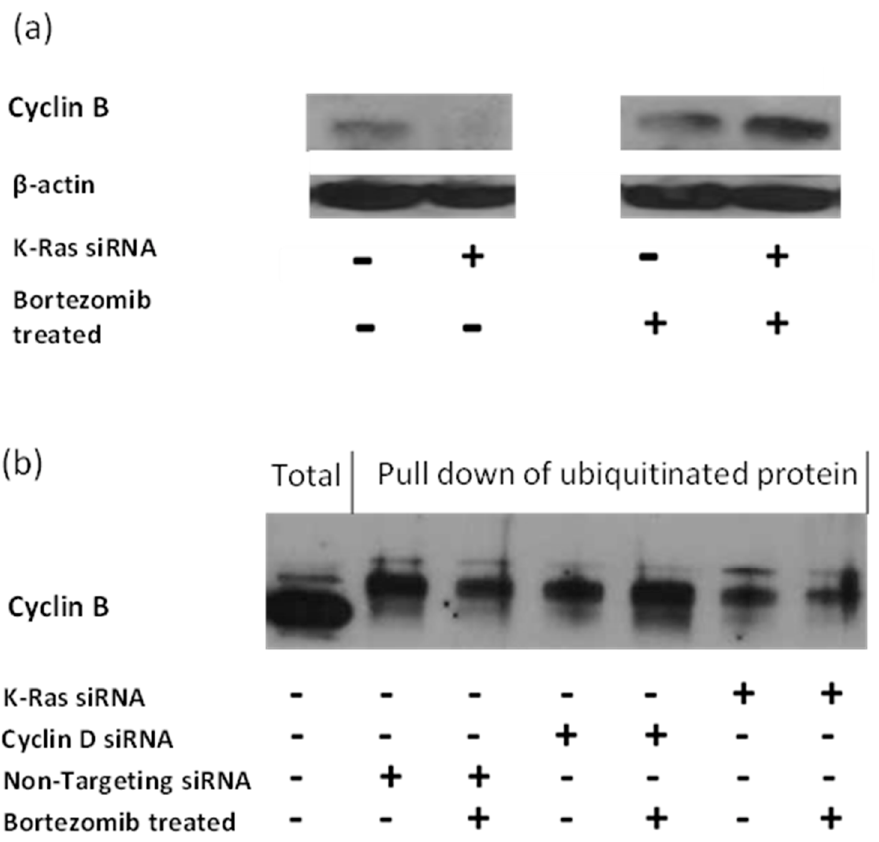
Figure 4. Effect of K-Ras depletion on G2 cyclins with or without Bortezomib treatment: ( a ) Western blot showing the effect of K-Ras depletion on total cyclin B in Suit-2 cells and how bortezomib treat- ment alters the effect. ( b ) Western blot showing the effect of bortezomib and siRNA in combination. K-Ras depletion decreases ubiquitinated cyclin B and bortezomib treatment decreases it further. Cyclin D depletion also decreases ubiquitinated cyclin B; however,